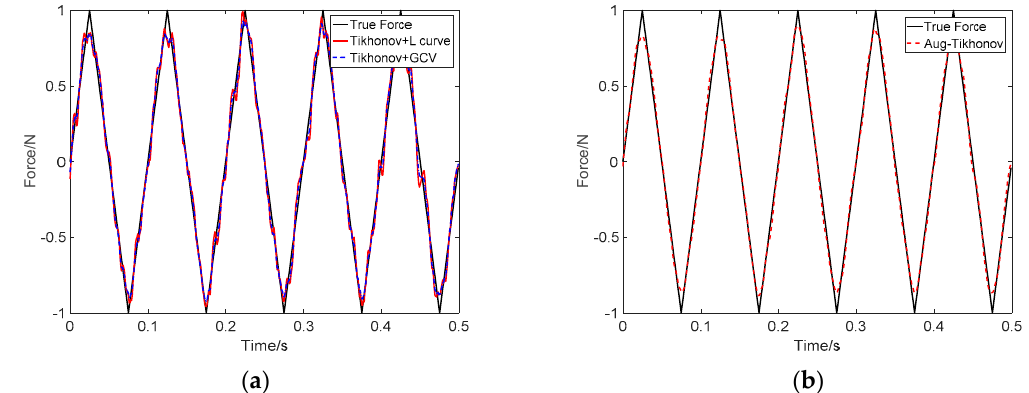
Figure 9. Identification result of triangle wave load at SNR 30 dB: ( a ) Tikhonov method; ( b ) the proposed method.